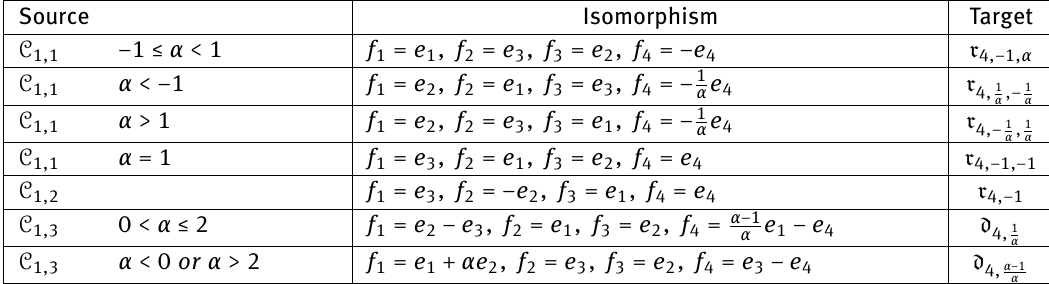
Table 7: Isomorphisms from the Lie algebras obtained in Table 5 onto the Lie algebras in Table 1 Source